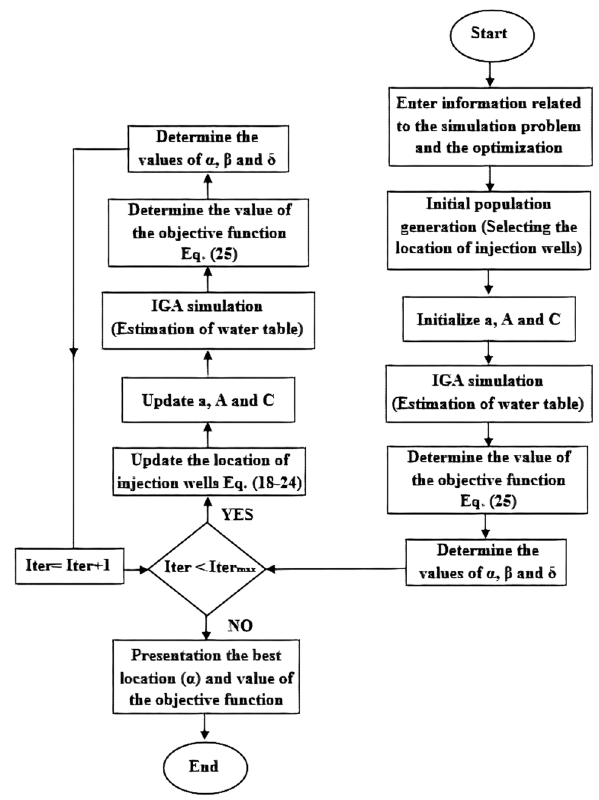
Fig. 4 Flowchart of the IGA-GWO numerical